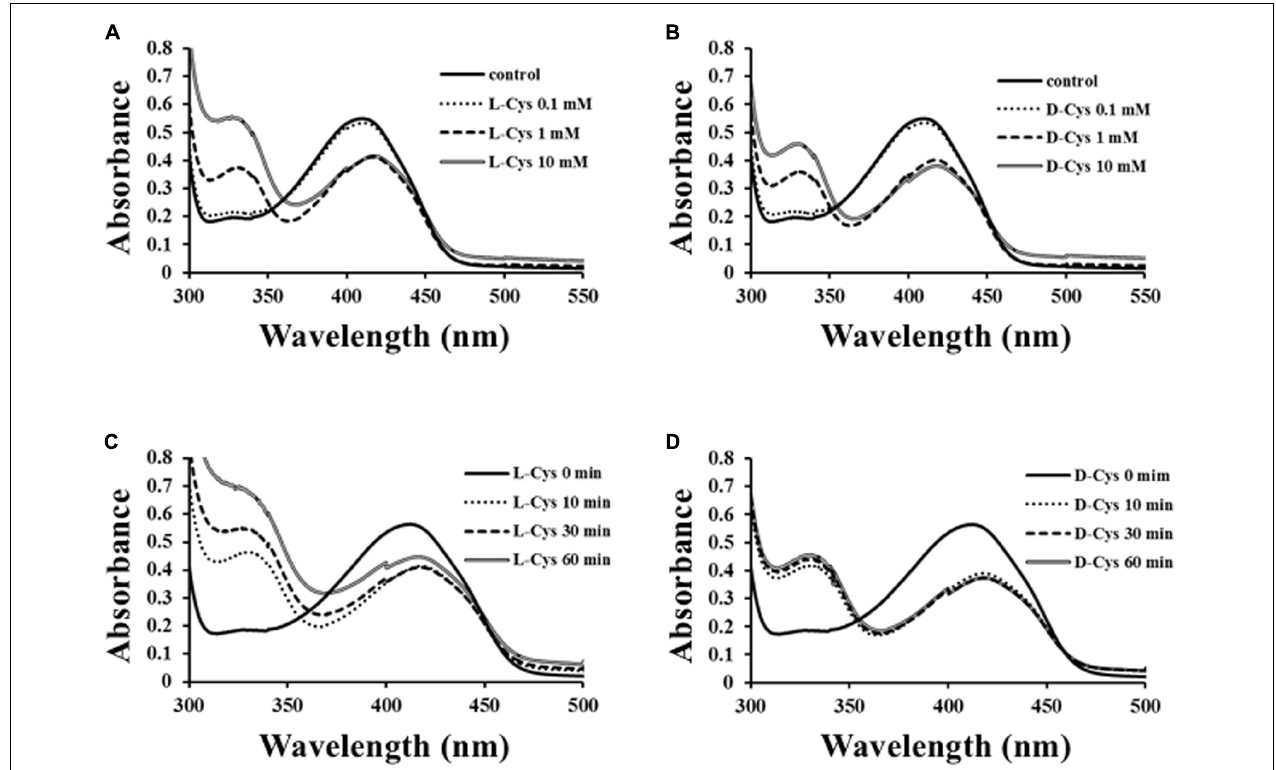
FIGURE 7 | Spectral analysis of β -lyase reaction. Dose-dependent (A,B) and reaction time-dependent (C,D) changes in UV-vis spectrum of WT Ls -MalY during β -lyase reaction with L - or D -Cys were assessed from 0 to 10 mM and from 0 to 60 min,